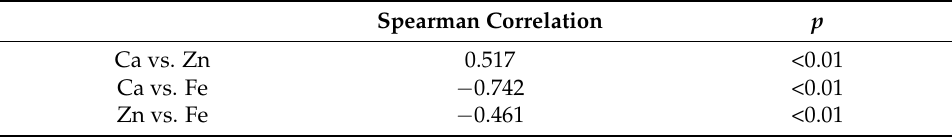
Table A1. Correlations between micronutrient contents in